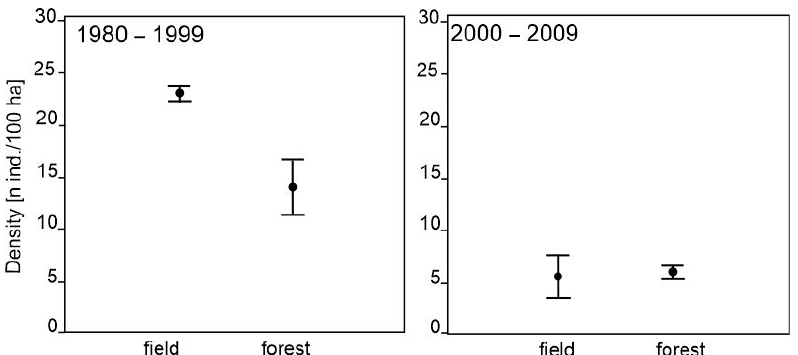
Figure 5. Mean ( ± SE) brown hare density in spring in open fields and forests in Rog ó w (central Poland), as assessed with the aid of the belt assessment and spotlight counts along transect routes (fields) and the driving census (forests) in the two study periods (1980–1989 and 1990–1999, pooled together: field n = 10, forest n = 8; and in 2000–2009: field n = 5, forest n = 10). Table 1. Comparison of indices of brown hare densities between the study area (Rog ó w) and a reference area placed in central Poland (Dobieszyn) in the past decades (Table S1). Values of the Kruskal–Wallis test (H) and p -values are given.